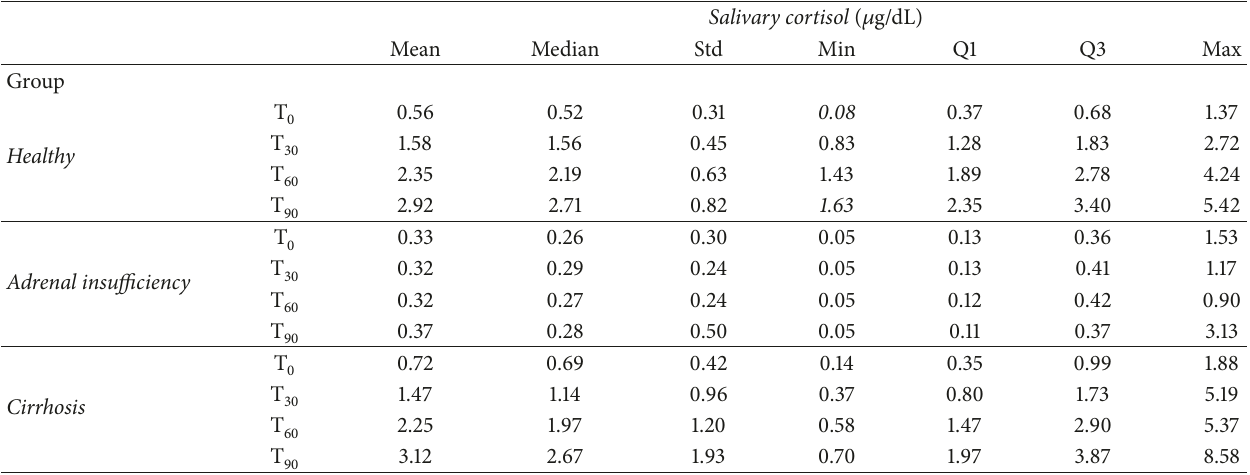
Table 4: Salivary cortisol concentrations in healthy volunteers, adrenal insufficient patients, and cirrhotic patients in the 250 𝜇 g ACTH test.